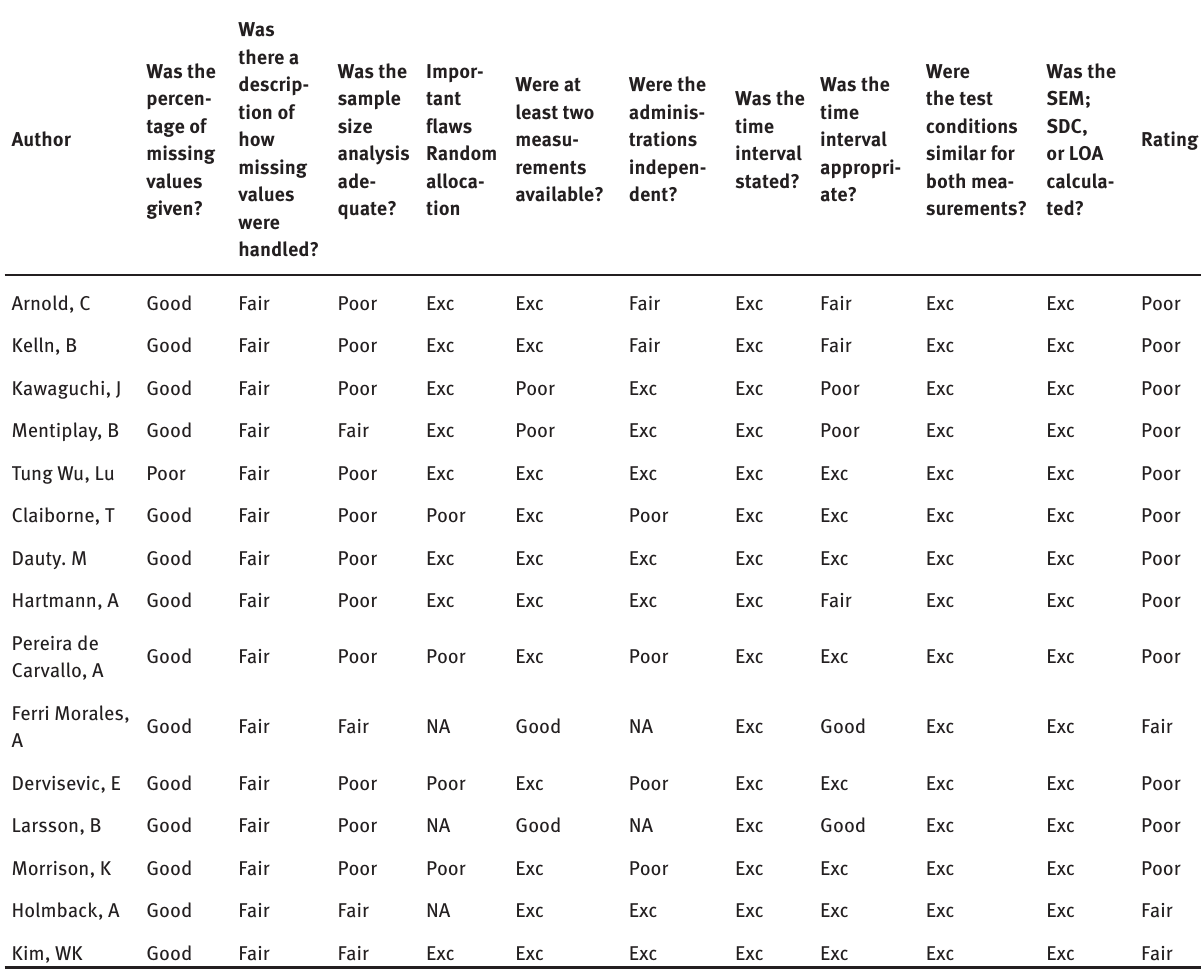
Table 5: Methodological quality by COSMIN checklist of the studies analyzing absolute reliability of HHD and ID.